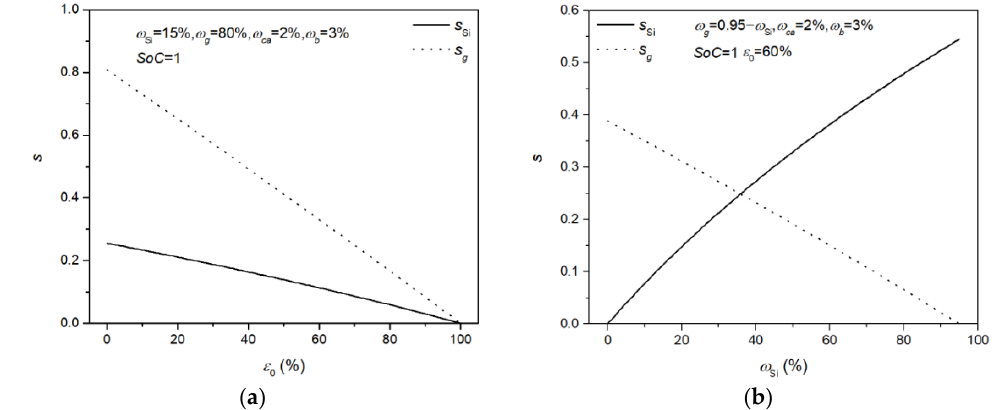
Figure 7. The swelling coefficients of Si and graphite for the Si-based electrode ( a ) as a function of ε 0 with ω Si = 15% at SoC = 1 and ( b ) as a function of ω Si for the Si-based electrode with ε 0 = 60% at SoC = 1.